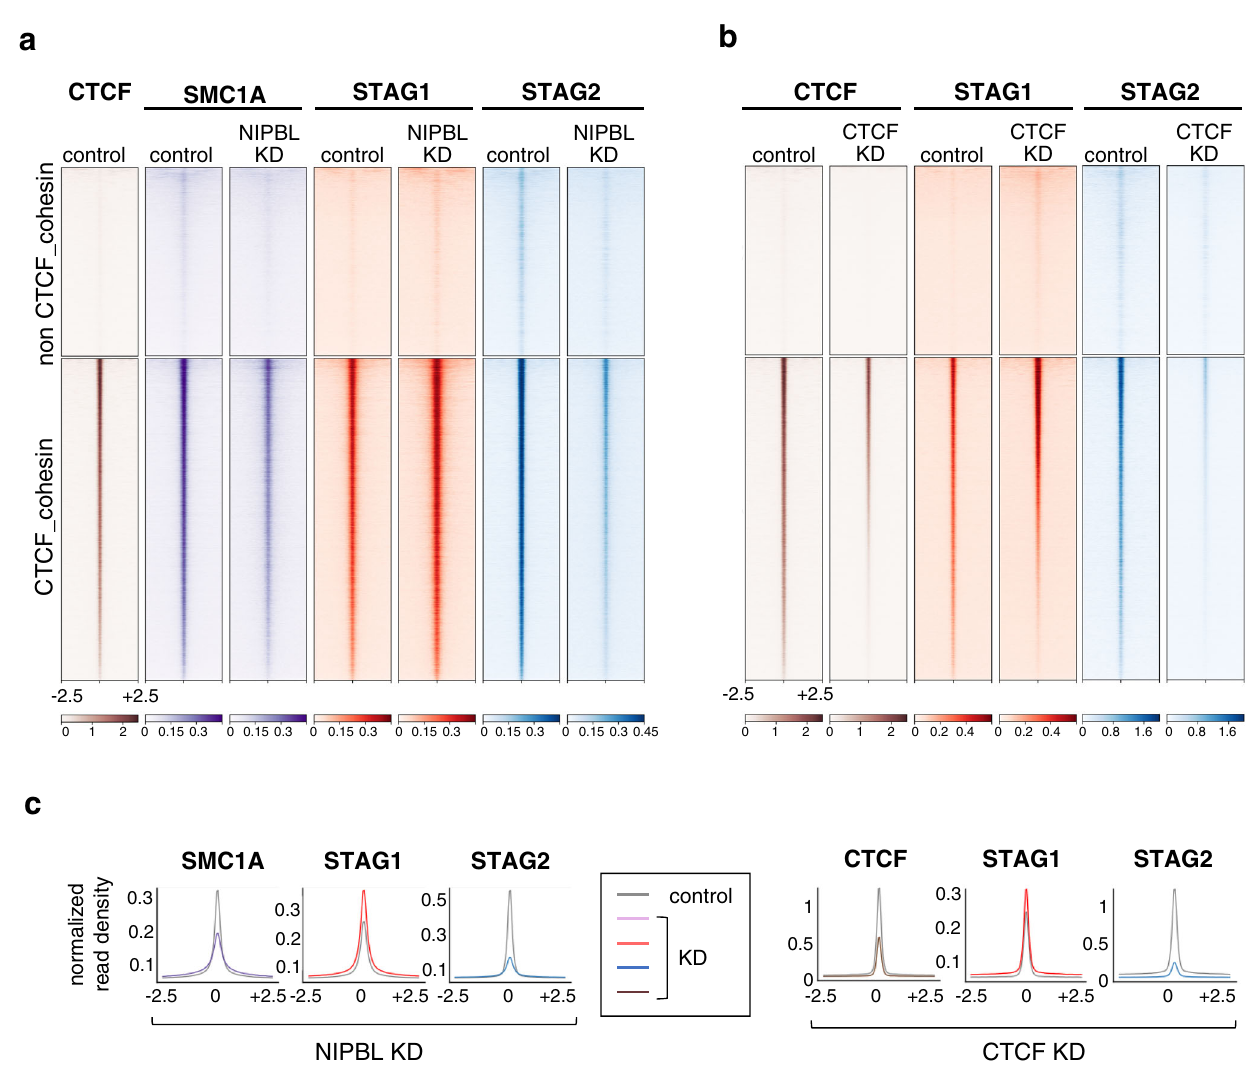
Fig. 4 | Cohesin-STAG1 accumulates at CTCF sites in NIPBL KD cells. a Distribution of three cohesin subunits in control and NIPBL KD MCF10A cells. Reads from calibrated ChIP-seq are plotted in a 5-kb window centered in the summits of cohesin positions with and without CTCF (24,912 and 14,607 positions, respectively). Information on replicates and additional datasets